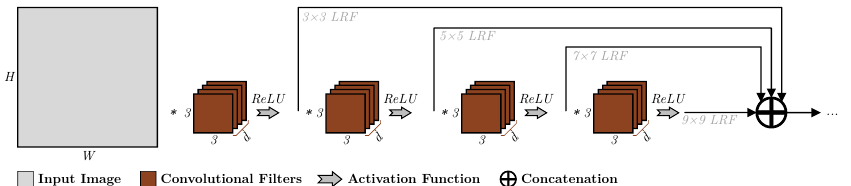
Figure 3. An example of an Inception v4 layer that employs larger kernel sizes and utilizes low-rank kernels for the implementation [11].